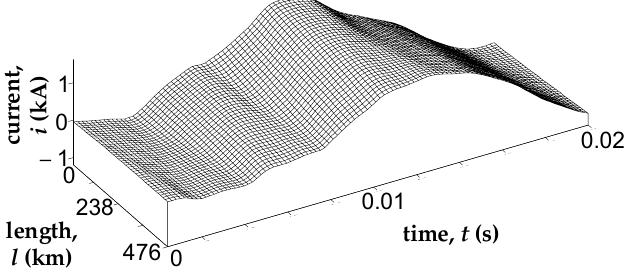
Figure 14. Temporal–spatial waveform of phase B current in the time range t  (0; 0.02) s.